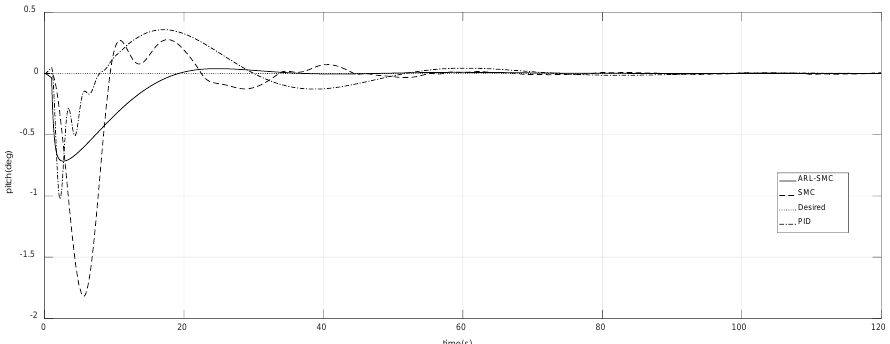
Figure 12. Depth response curves of simulation.